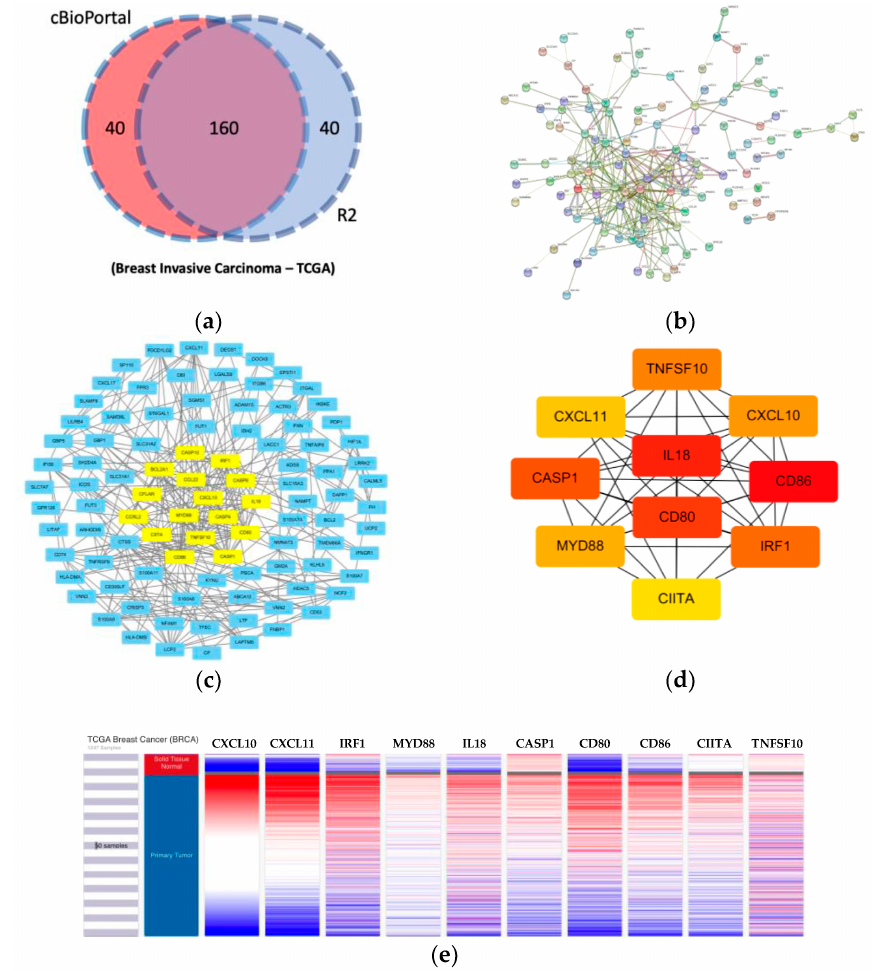
Figure 5. PPI network construction and hub genes analysis of KMO-correlated genes. ( a ) Venn diagram representing the intersection of the top 200 correlated genes with KMO based on the cBioPortal and R2 database and breast invasive carcinoma (TCGA, BRCA); ( b ) the protein interaction nodes of KMO-correlated genes predicted using the STRING database; ( c ) cluster analysis of KMO- correlated genes using the MCODE plugin of Cytoscape; ( d ) hub genes analyzed using the cytoHubba plugin of Cytoscape; ( e ) hierarchical clustering of hub genes constructed using the UCSC Xena online exploration